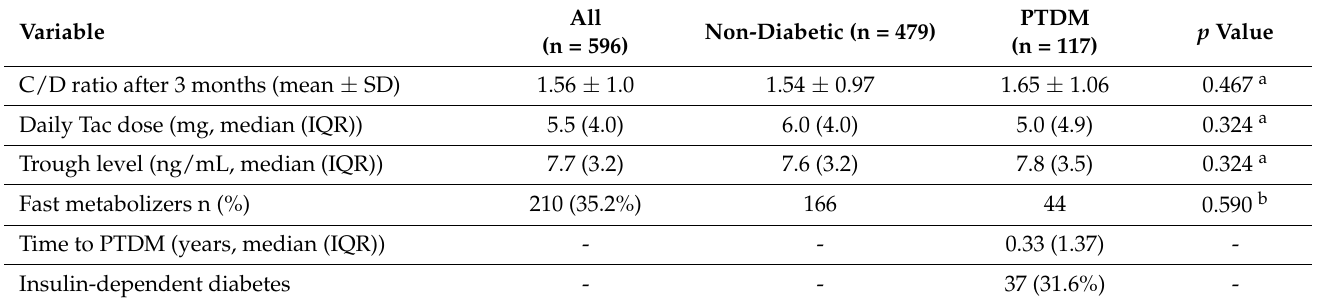
Table 2. Patients’ outcome data.